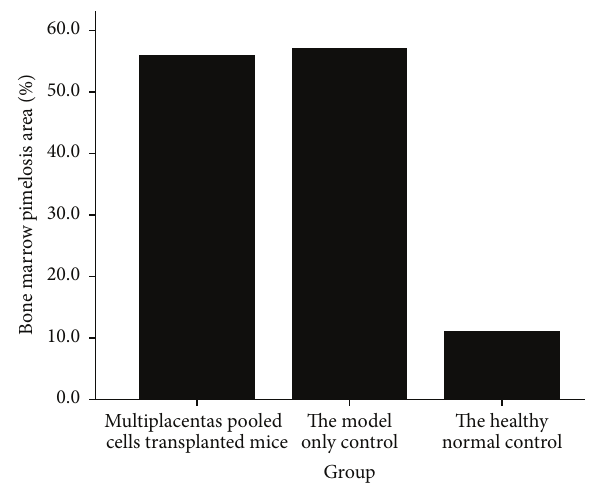
Figure 4: Mice bone marrow pimelosis area at day seven after placentas pooled cells